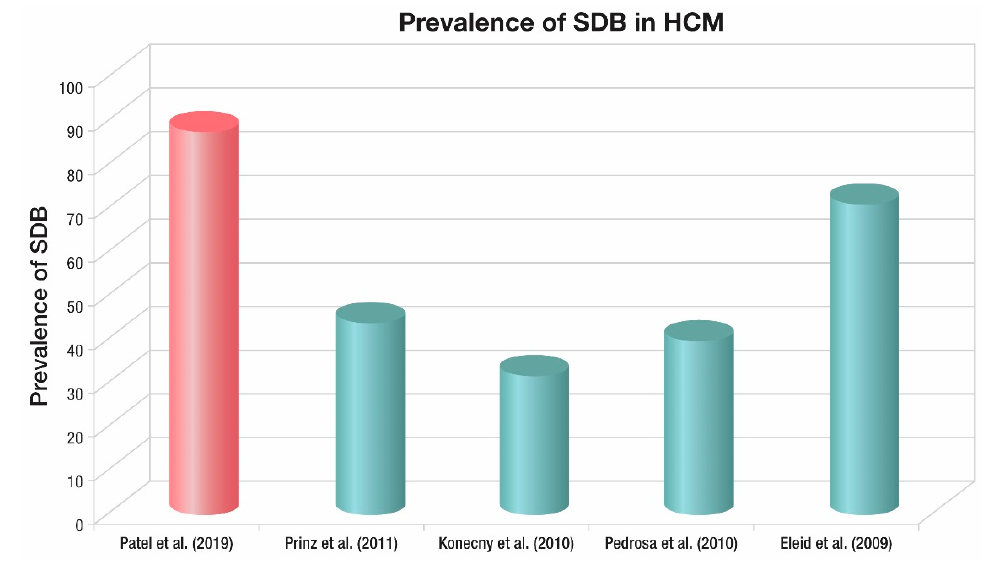
Figure 1. Summary of Prevalence of SDB in HCM. Table 1. Summary of all published studies assessing sleep disordered breathing in patients with hypertrophic cardiomyopathy (HCM). Baseline characteristics are